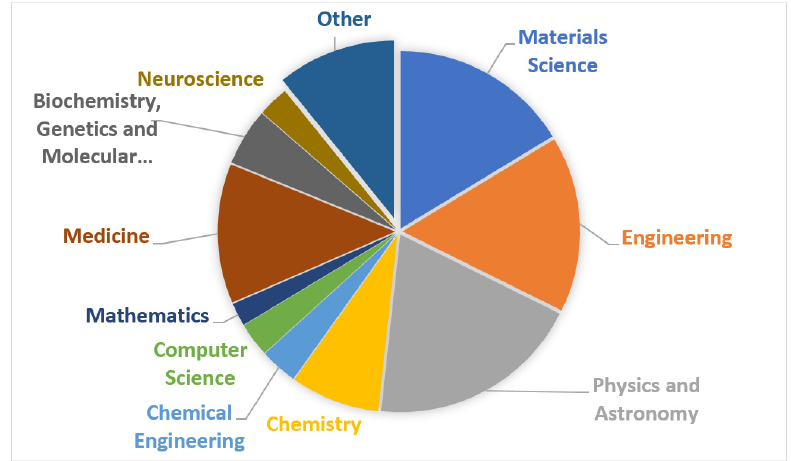
Figure 2. Subject areas of contributions dedicated to magnetic materials and systems (source: Scopus).